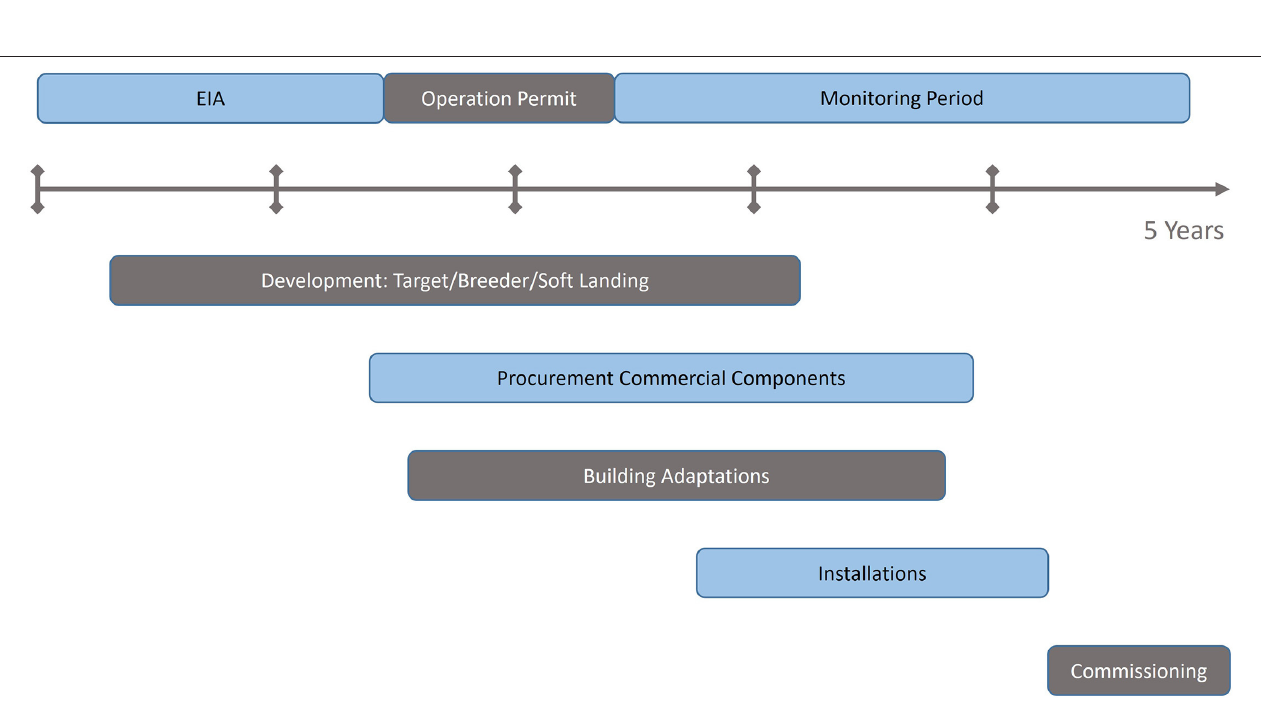
FIGURE 15 | Potential integration timeline under the view of the constraints at MedAustron taking actual development status and legal constraints into account.